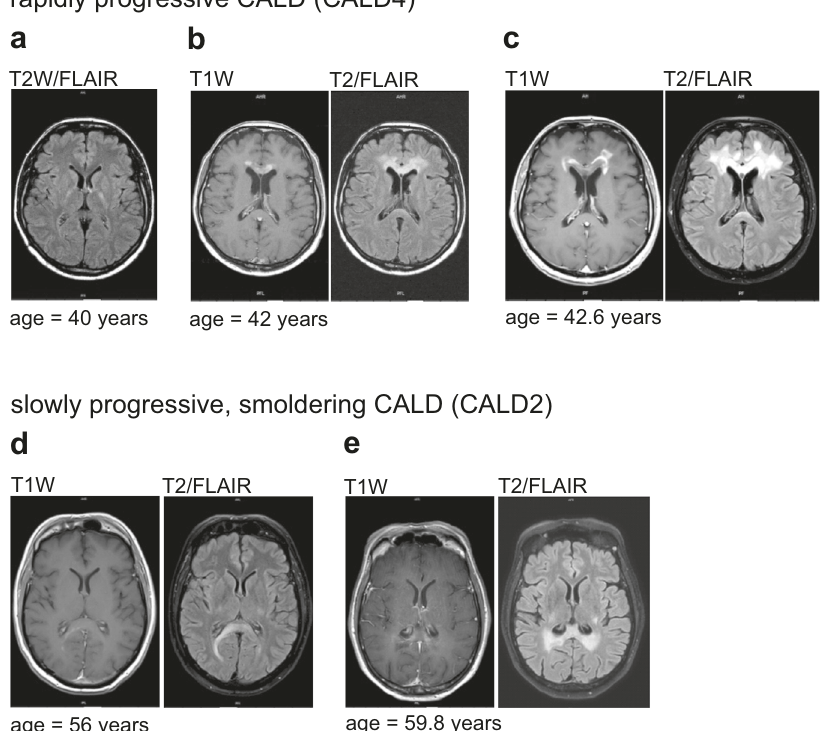
Fig. 3 MRI analysis of slowly progressive smoldering in fl ammation in CALD. a T2-weighted (FLAIR) sequence before the onset of CALD in patient CALD4 with classical, rapidly progressive disease course. b , c Frontal lobe cerebral in fl ammatory lesion with pronounced Gd-enhancement in T1-weighted (T1W) images and elevated FLAIR signal in the genu of the corpus callosum and frontal white matter, which was not seen two years earlier ( a ) and with the severe progression of the enhancing lesion seven months later. d , e MRI scans of a CALD patient (CALD2) with atypical, slowly progressive smoldering in fl ammation. d Hazy Gd-enhancement in T1W images and mildly elevated FLAIR signal in the splenium of the corpus callosum and posterior white matter. e Four years later, lesions had progressed mildly with diffuse marginal Gd-enhancement still notable, suggesting chronic smoldering in fl